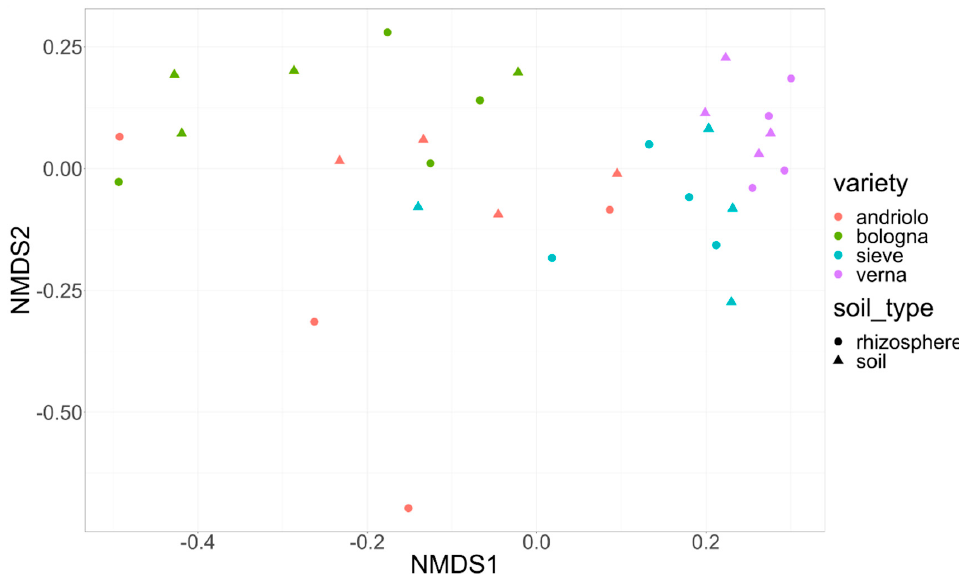
Figure 3. Soil sample distribution according to bacterial community. Nonmetric Multidimensional Scaling of soil and rhizosphere bacterial community. Ordination based on Bray–Curtis distance. Colors indicate the wheat variety, and shapes refer to the type of sample (circle = rhizosphere soil, triangle = bulk soil). Stress = 0.15.